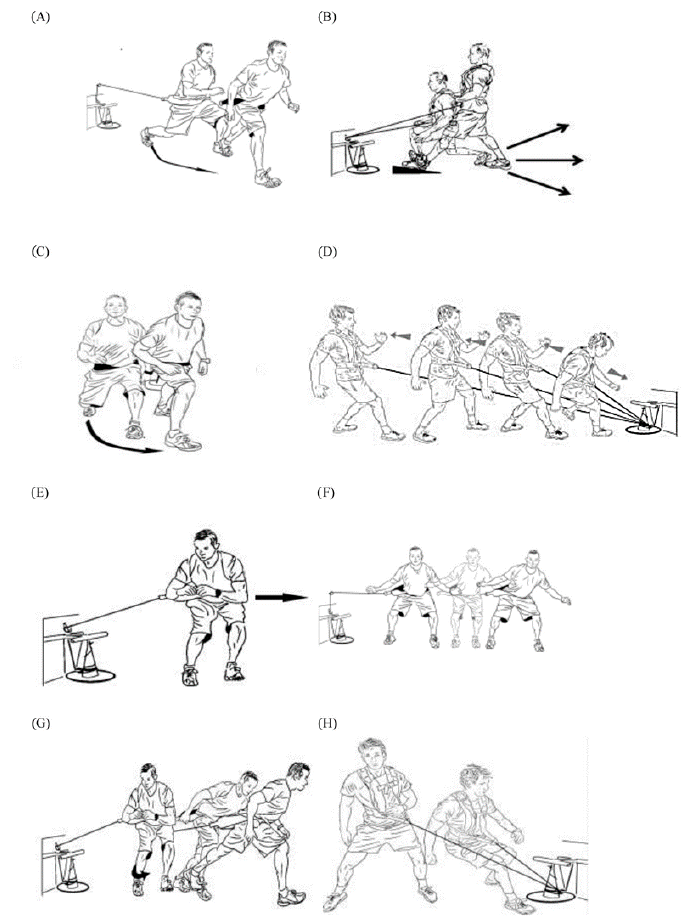
Figure 1. Functional eccentric overload variable unilateral horizontal training program and the corresponding force vector application: ( A ) side-step (posteroanterior/anteroposterior), ( B ) backward lunges (anteroposterior/posteroanterior), ( C ) crossover cutting (rotational/anteroposterior), and ( D ) landings and backward lunges; and functional eccentric overload variable unilateral lateral training program: ( E ) lateral squat (mediolateral/lateromedial), ( F ) defensive-like shuffling steps (mediolateral/lateromedial), ( G ) lateral crossover cutting (rotational/lateromedial), and ( H ) 90° lunge (rotational/lateromedial).